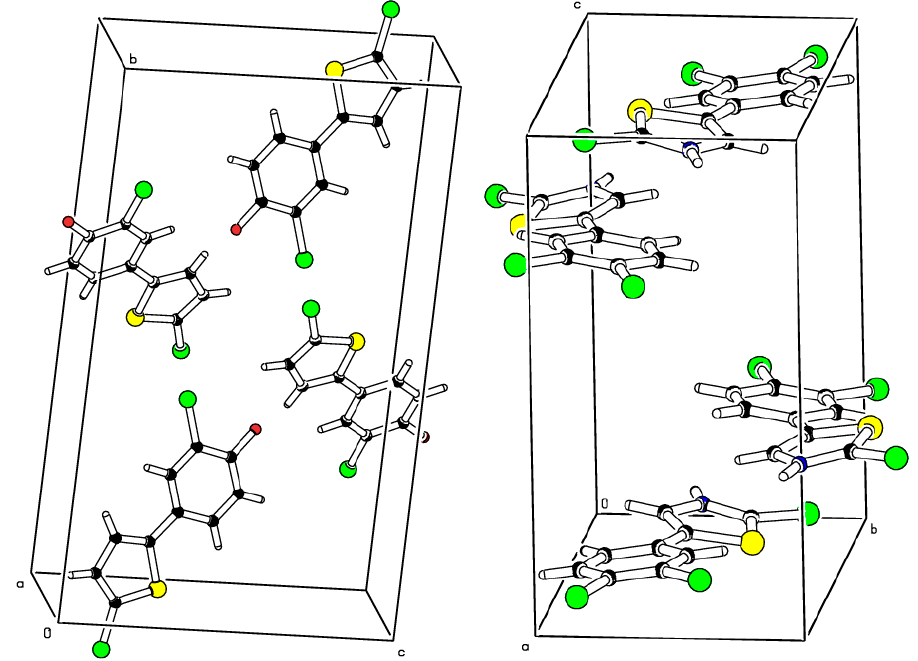
Figure 4. Unit cell diagrams of 2d and 2f . (Ball color: green, Cl; red, F; yellow, S; black and blue, C).